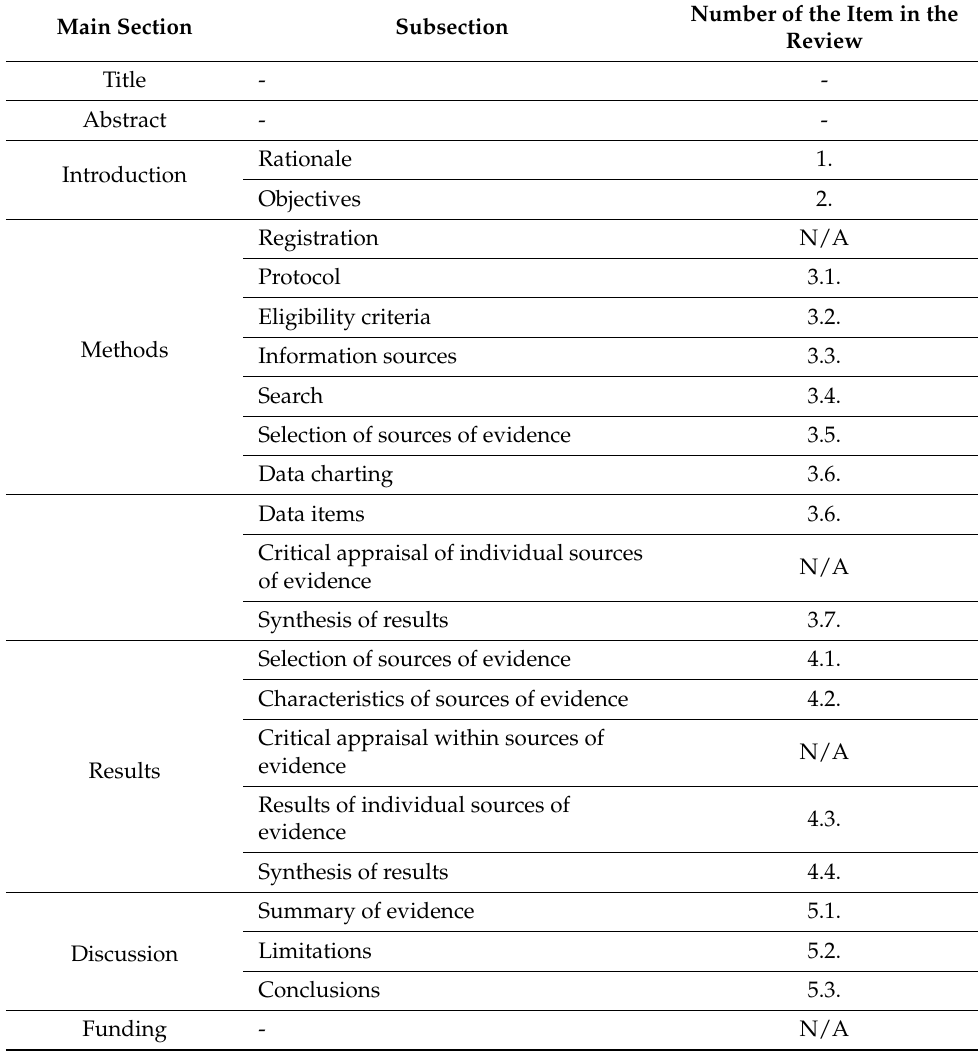
Table A1. Summary of PRISMA-ScR checklist. The PRISMA-ScR checklist provides subsections for the introduction, methods, results, and discussion that should be followed in scoping reviews.